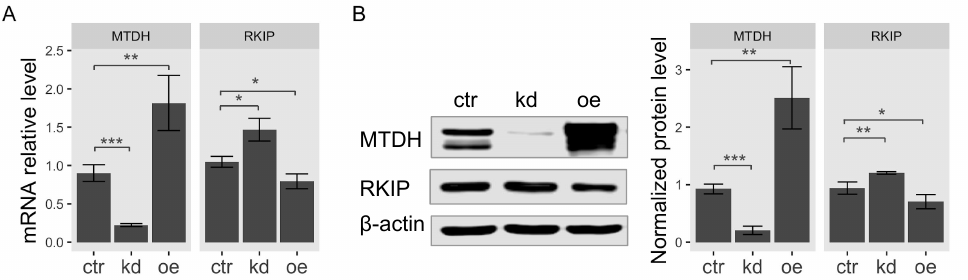
Figure 3. Transcriptional activation of RKIP gene in MTDH -knockdown or -overexpressing cells. Lentiviral vector with shMTDH sequence and FLAG-MTDH plasmid were used for generating knockdown and overexpression in MCF-7 cells, respectively. ( A ) qRT-PCR analysis. The relative mRNA transcripts of MTDH or RKIP in MTDH -knockdown cells ( kd ), MTDH -overexpressing cells ( oe ), or control cells ( ctr ) were determined by qPCR analysis. The relative levels were normalized to the level of glyceraldehyde 3-phosphate dehydrogenase (GAPDH). Data represent the means ± S.D of the PCR reactions in triplicate. ( B ) Western blot analysis for RKIP expression. Total cellular proteins extracted from either MTDH -knockdown cells ( kd ) or MTDH -overexpressing cells ( oe ) were subjected to Western blotting analysis ( left ) using antibodies against MTDH or RKIP. The relative expression of each protein normalized to β -actin (an internal control). Data indicate the mean value ± S.D of at least three independent experiments. *** <0.005,** <0.01, * <0.05 p